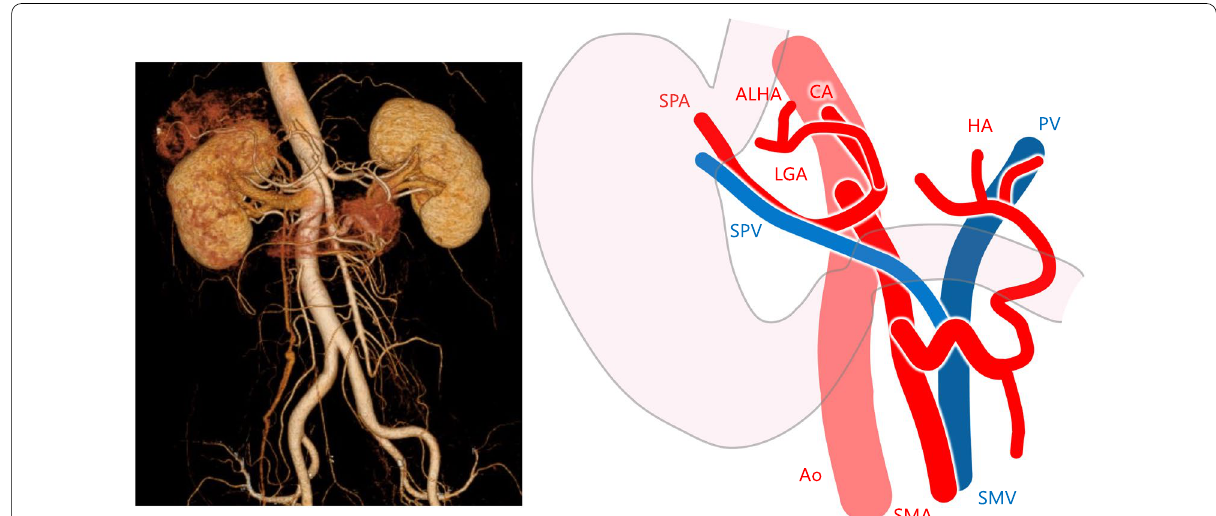
Fig. 3 Three-dimensional reconstruction of a computed tomography angiogram revealed the absence of the common hepatic artery. In addition, the proper HA was derived from the SMA through the gastroduodenal artery, and an ALHA arose from the LGA. SPA splenic artery, ALHA accessory left hepatic artery, CA celiac artery, LGA left gastric artery, SPV splenic vein, HA hepatic artery, PV portal vein, Ao aorta, SMA superior mesenteric artery,